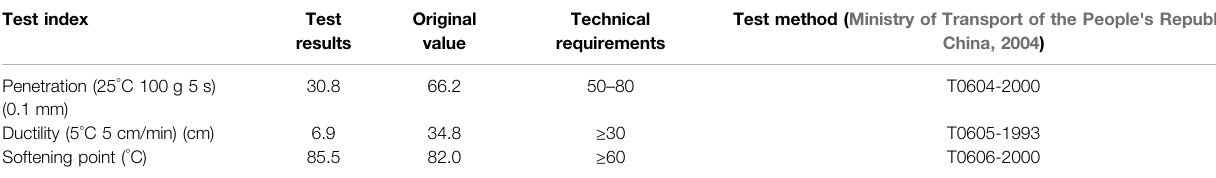
TABLE 4 | Test index of recovered SBS modi fi ed asphalt.